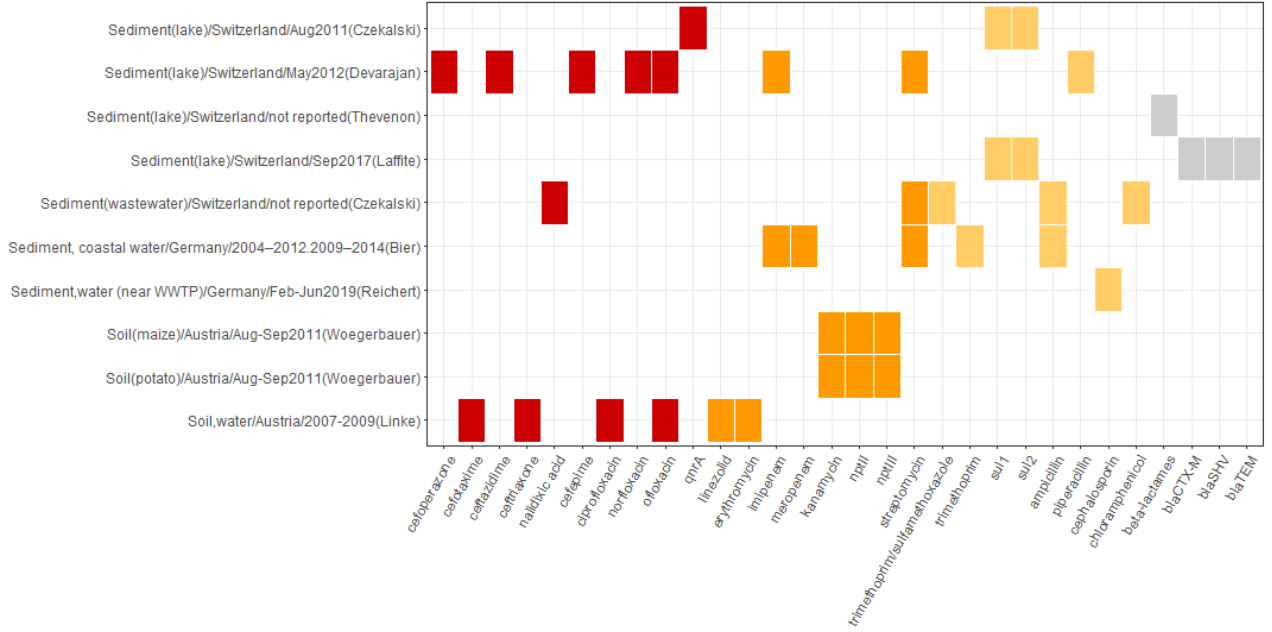
Figure 7. Overview of the occurrence of reported antibiotic resistance patterns in sediment and soil. The horizontal axis depicts resistance patterns as reported in the primary studies and includes antibiotic compounds, antibiotic classes, resistance mechanisms, and ARGs. The vertical axis represents the source of resistance associated with resistance patterns depicted on the horizontal axis as follows: source of sample/Country of study/Sampling period/(First author of the reporting study). The color profile represents the WHO CIA list categories: red, Critically important: Highest Priority; orange, Critically important: High Priority; yellow, Highly important; grey, not